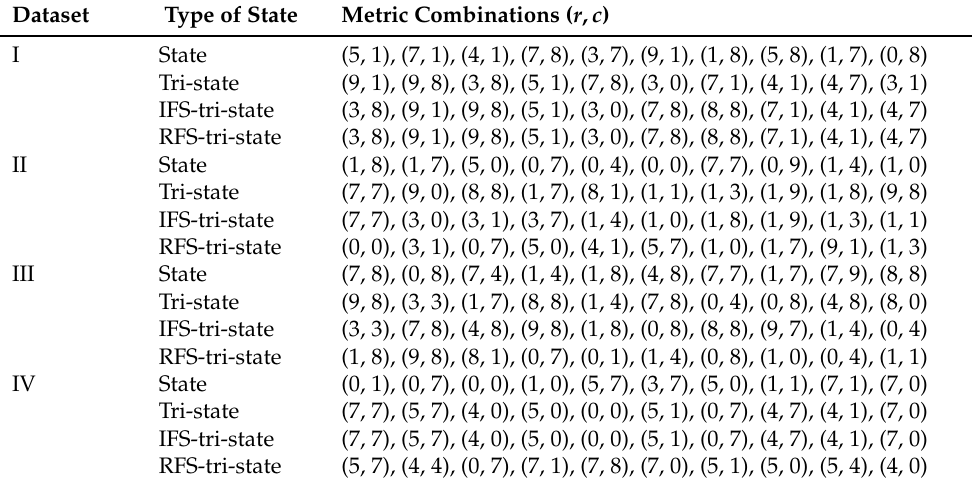
Table 7. The top 10 metric combinations for precision.